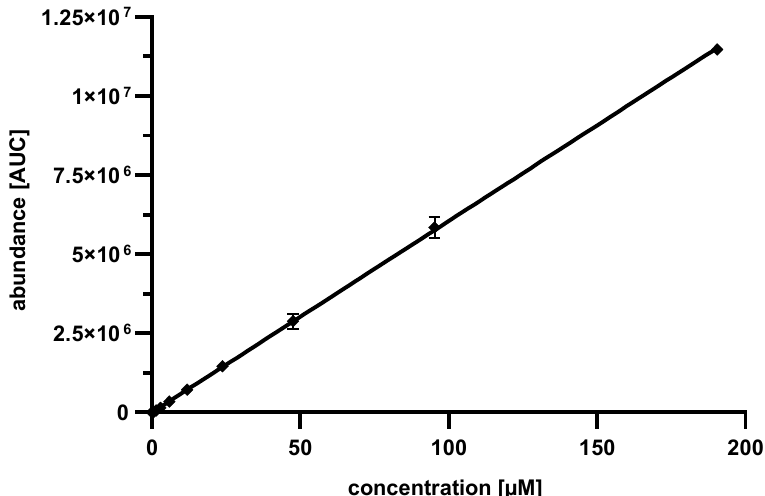
Figure 5. 13 C 9 , 15 N 1 phenylalanine standard curve after acidic hydrolysis. The error was calculated by standard deviation, the number of experiments was n = 3, the coefficient of determination for the linear fit was 0.9999.